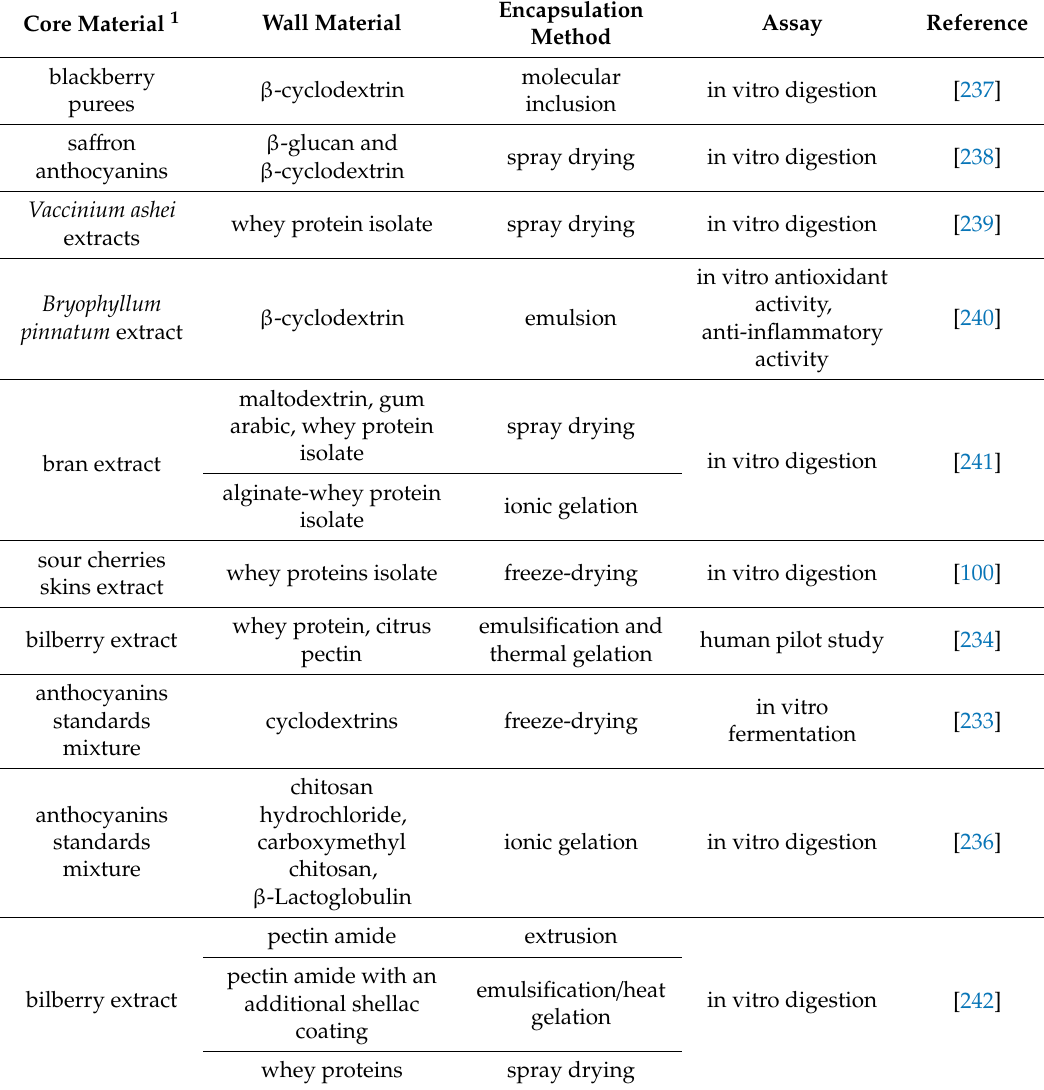
Table 3. Encapsulation of